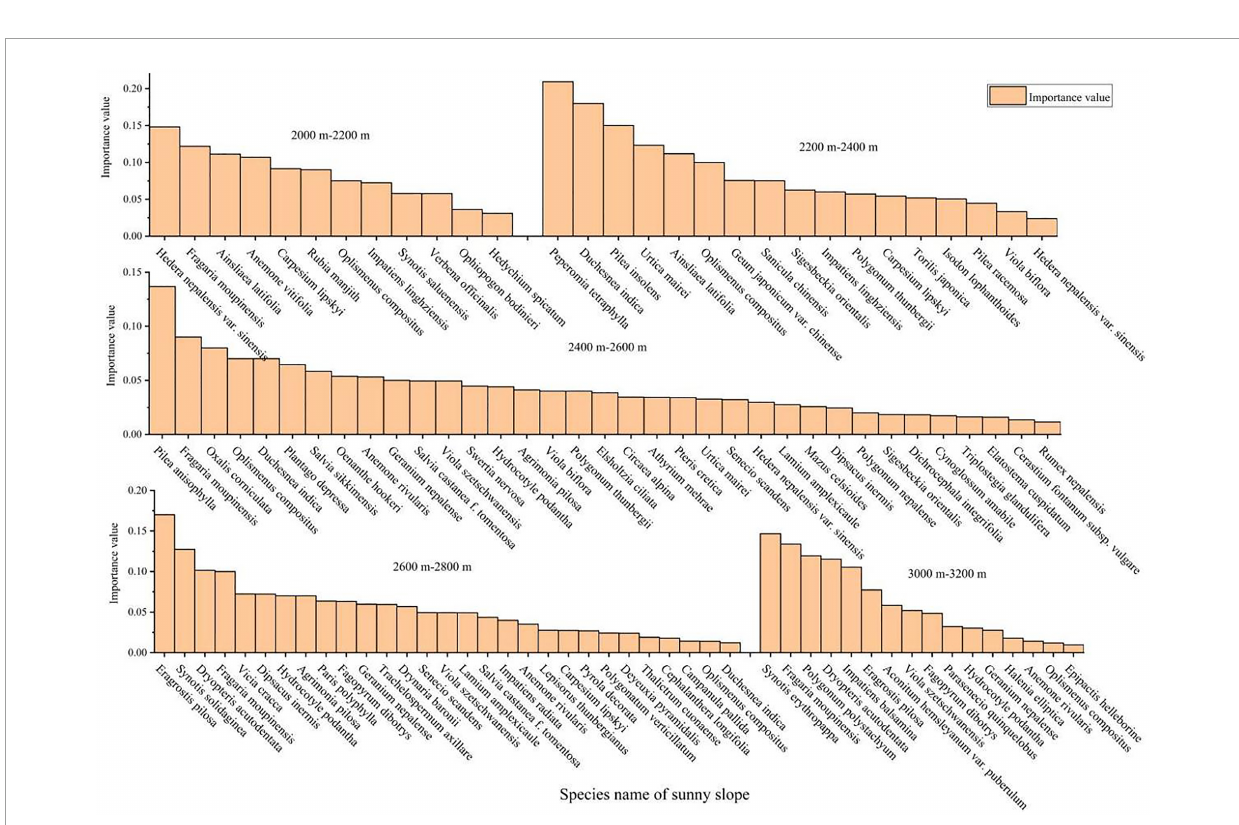
FIGURE3 Important values of herbaceous plants in different altitude gradients of sunny